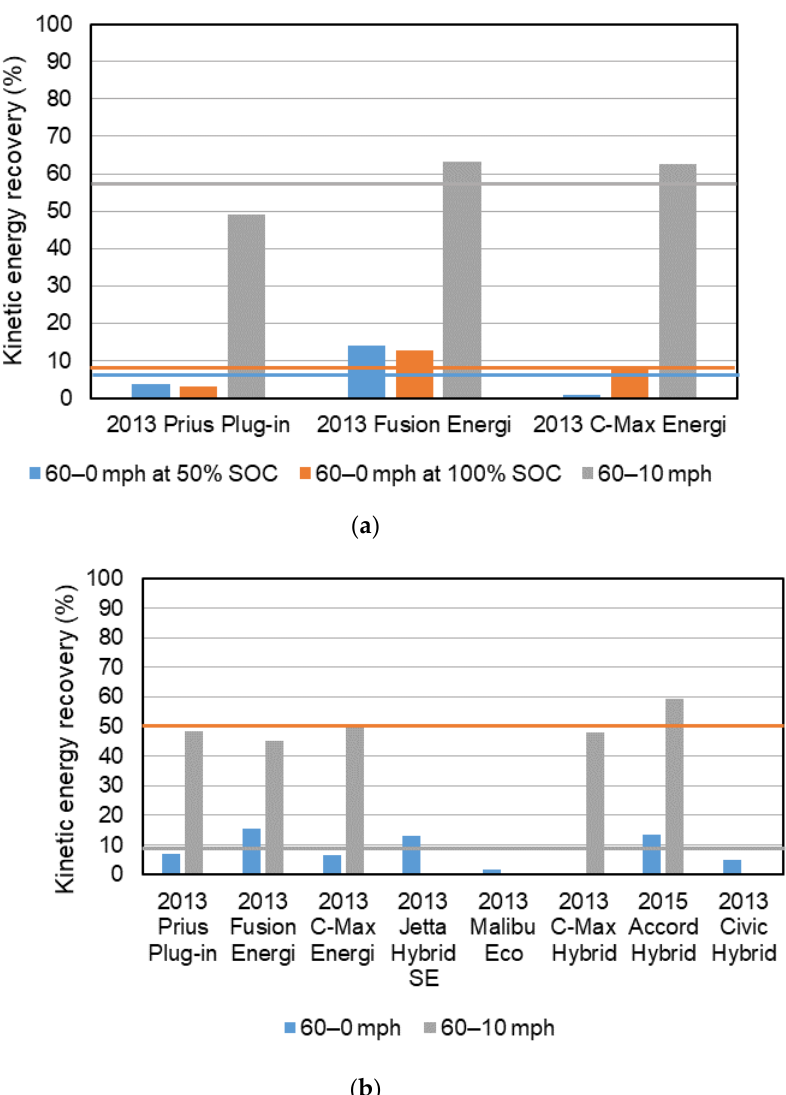
Figure 7. Kinetic energy recovery during regenerative braking during ( a ) CD mode ( b ) CS mode. Note 60–10 mph braking conditions were under coasting in drive condition on dry surface. Test run data were cut off when the vehicle reached 10 mph.